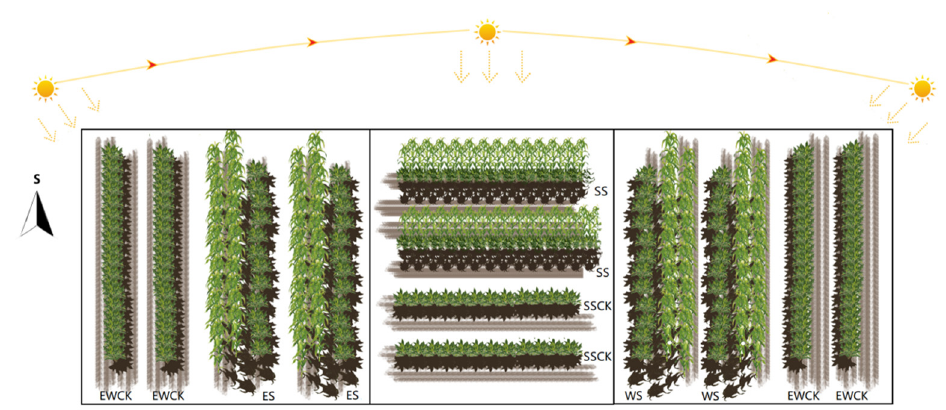
Figure 1. Field layout model of the ecological shading treatments by intercropping maize plants in tea plantation (Note: ES—east shading; WS—west shading; EWCK—control of the WS and ES shading treatments; SS—south shading; SSCK—control of the SS shading treatment) .